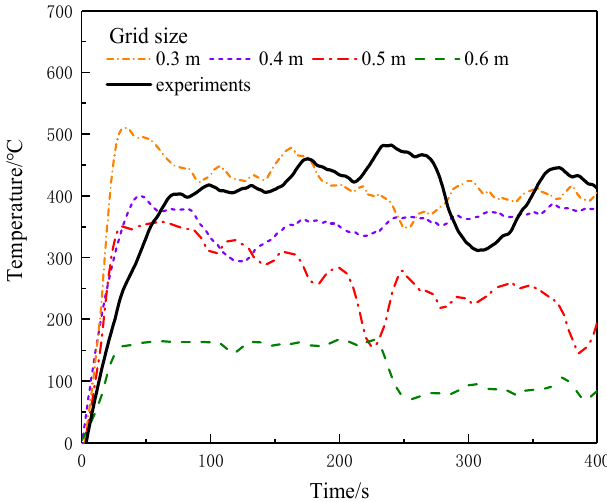
Figure 2. Temperature comparison chart for different grid sizes.